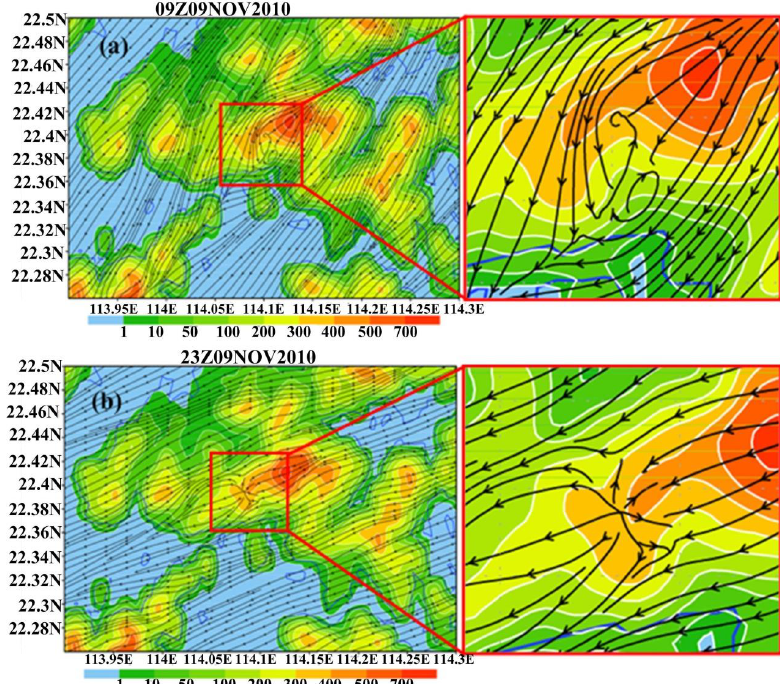
Fig. 9. Simulation of mountain–valley breezes on 9 November 2010: (a) valley breezes at daytime; (b) mountain breezes at nighttime.